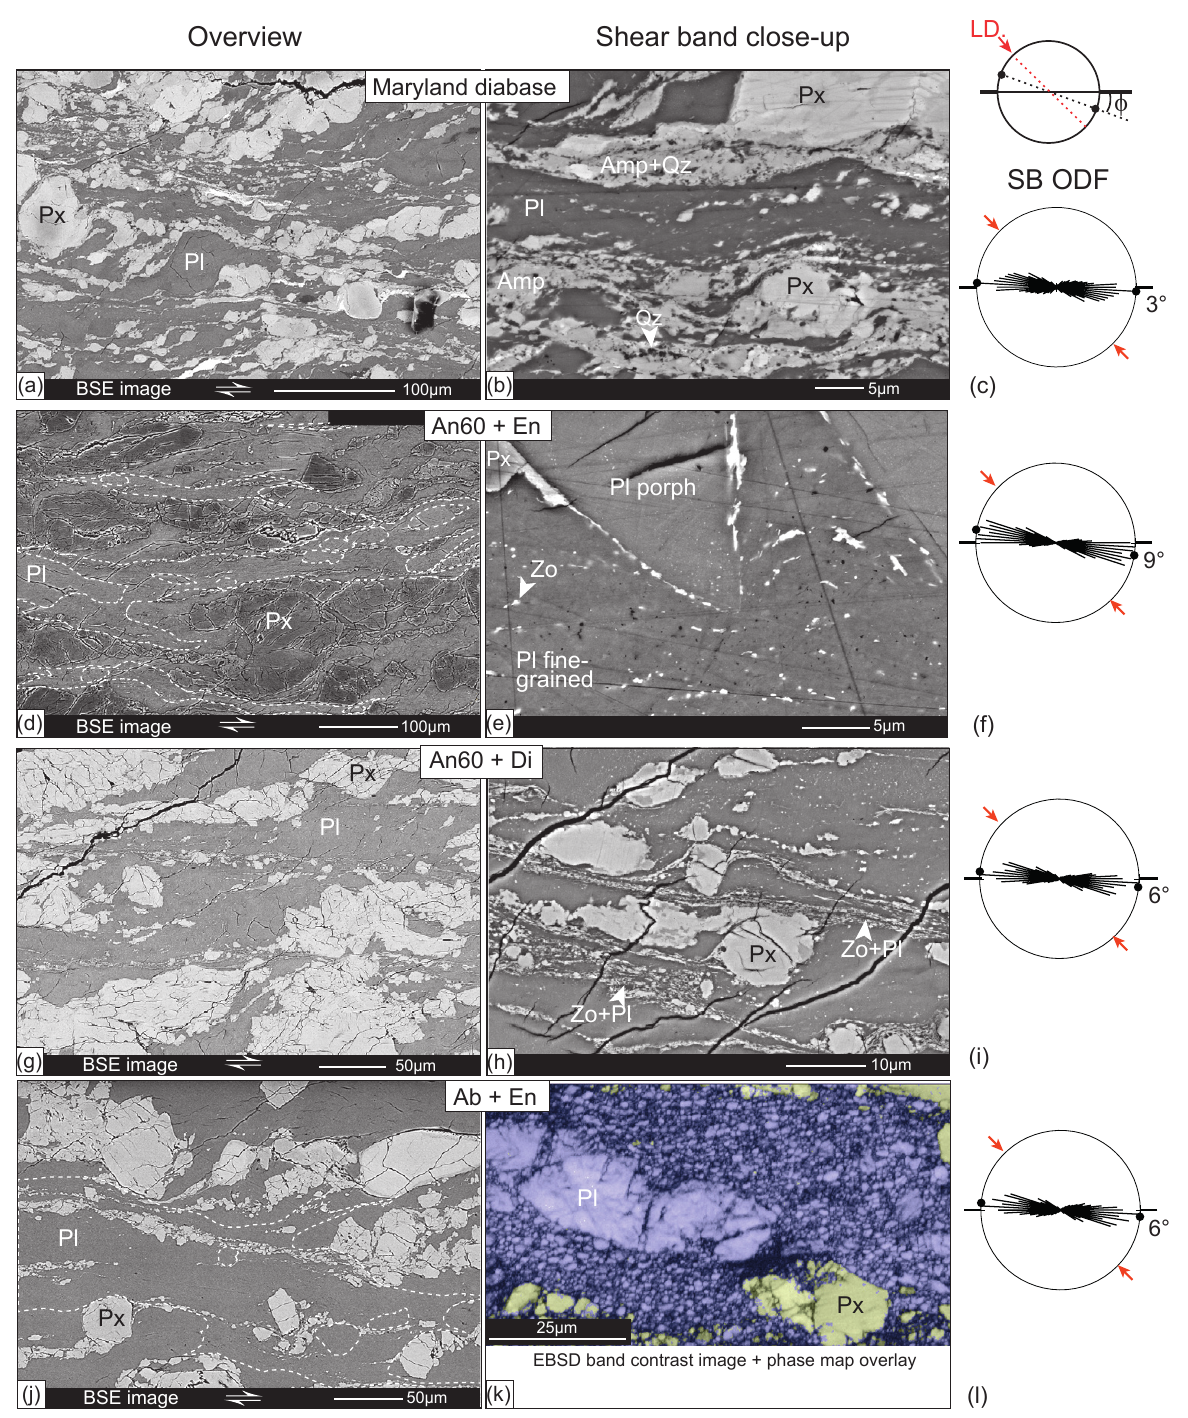
Figure 5. Microstructures of experiments at Pc ≈ 1 . 0GPa. (a–c) Maryland diabase sample material. (b) Shear bands are fine-grained and often polymineralic, with the main constituents Pl, Amp, and Qz. (d–f) An60+En sample material. Due to the low iron content, pyroxene appears darker than the plagioclase in BSE–SEM images. In panels (d) and (j) , shear bands are traced with white dotted lines. (e) Fine- grained Pl + Zo in a shear band next to a Pl porphyroclast. (g–i) An60+Di sample material. (j–l) Ab+En sample material. (h) EBSD band contrast image with transparent phase map overlay. Plagioclase appears blueish, pyroxene yellowish. Rose diagrams represent the orientation of the shear bands, and black dots indicate the preferred trend of shear band segments. Red arrows indicate the direction of loading. The angle, φ , between the shear zone boundary (or forcing block) and the preferred shear band trend is